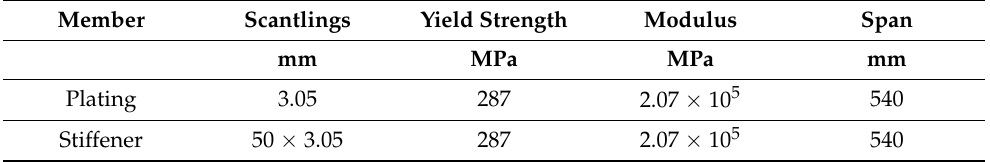
Table 1. Scantlings of box girder MST-3 in the experiment [23].